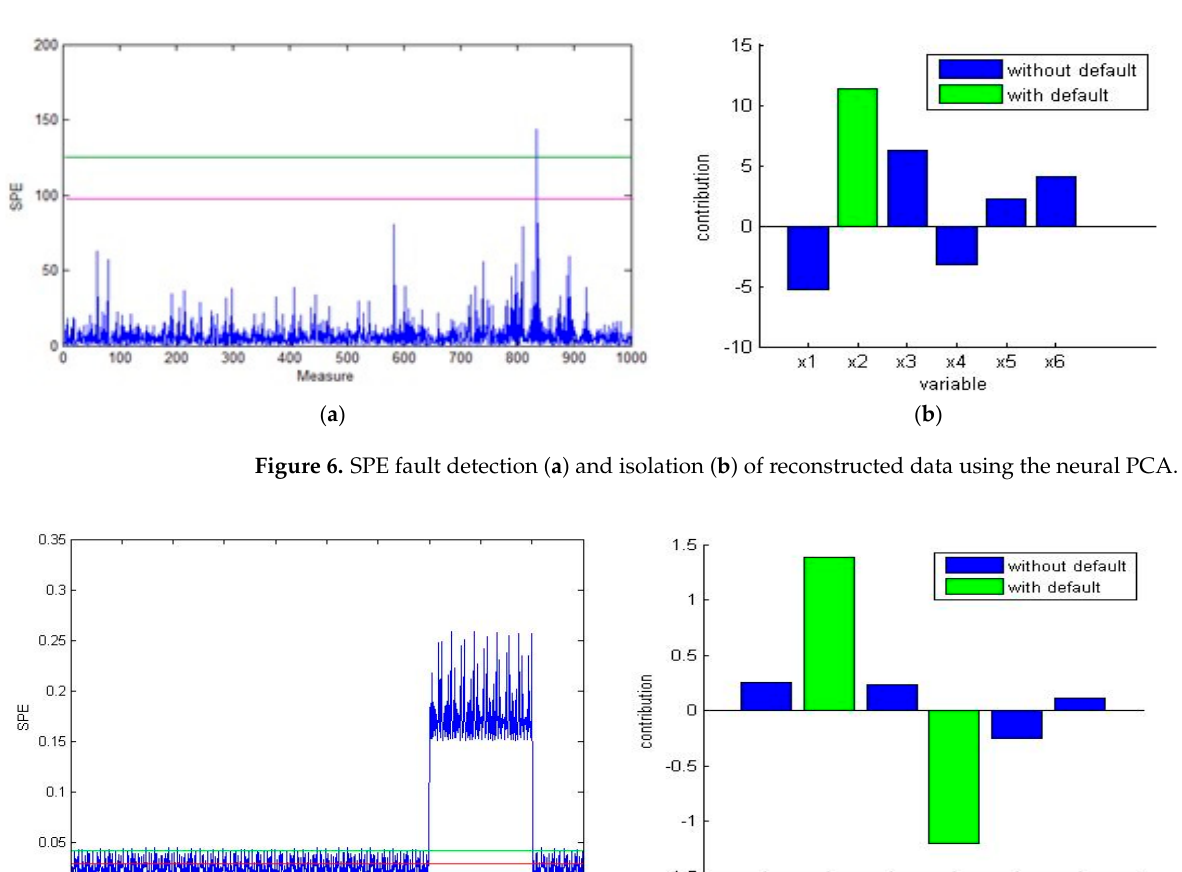
Figure 5. SPE fault detection of reconstructed data using the traditional PCA.